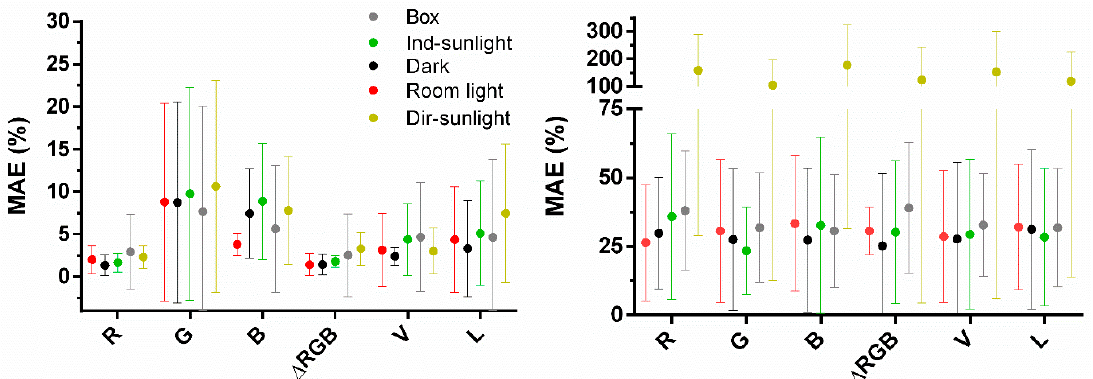
Figure 8. Left, MAEs for pH predictions (n = 15), right, MAEs for [GNP] predictions (n = 18), at various illumination conditions for R, G, B, ∆ RGB, V, and L channels without use of a box and in a box at room illumination conditions. Images under dark (black balls) background were taken in a dark room; room background (red balls) in a windowless laboratory illuminated with a tube light bulb; indirect sunlight (green balls) in a windowsill at a cloudy day; direct sunlight (dark yellow balls) in a windowsill in full sunlight.